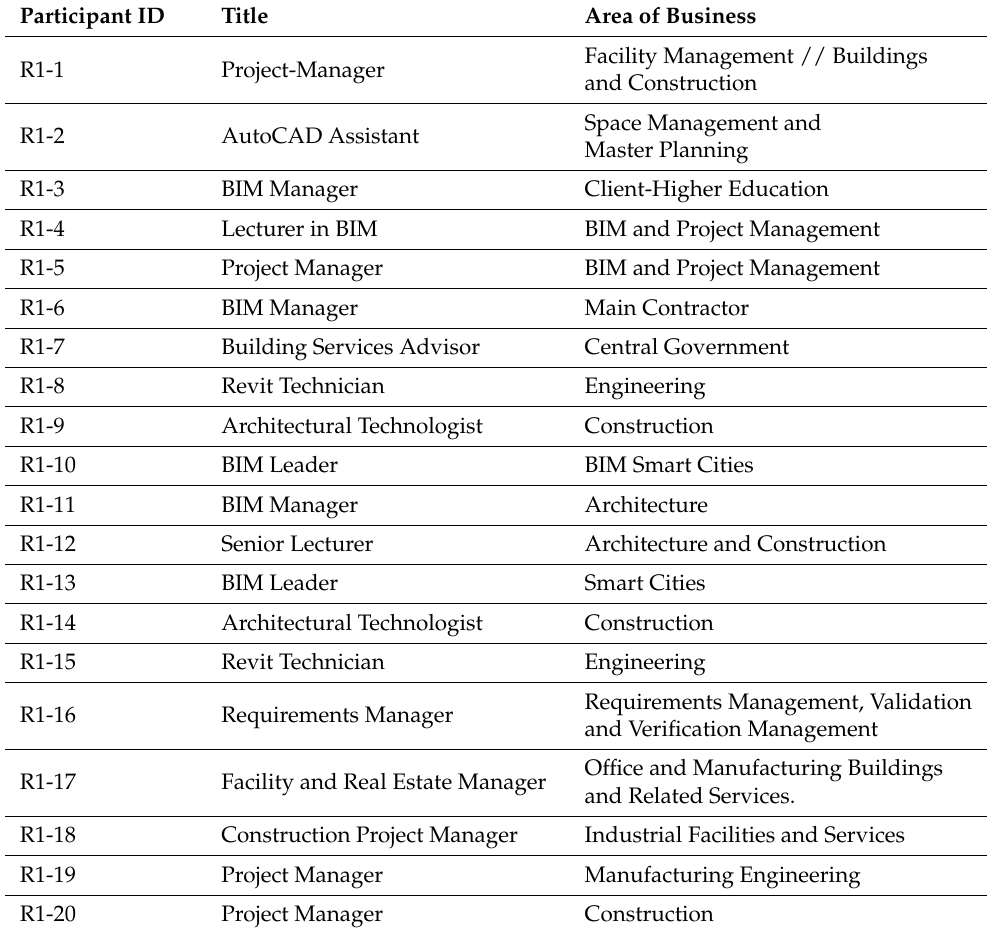
Table 1. Participants in the Validation